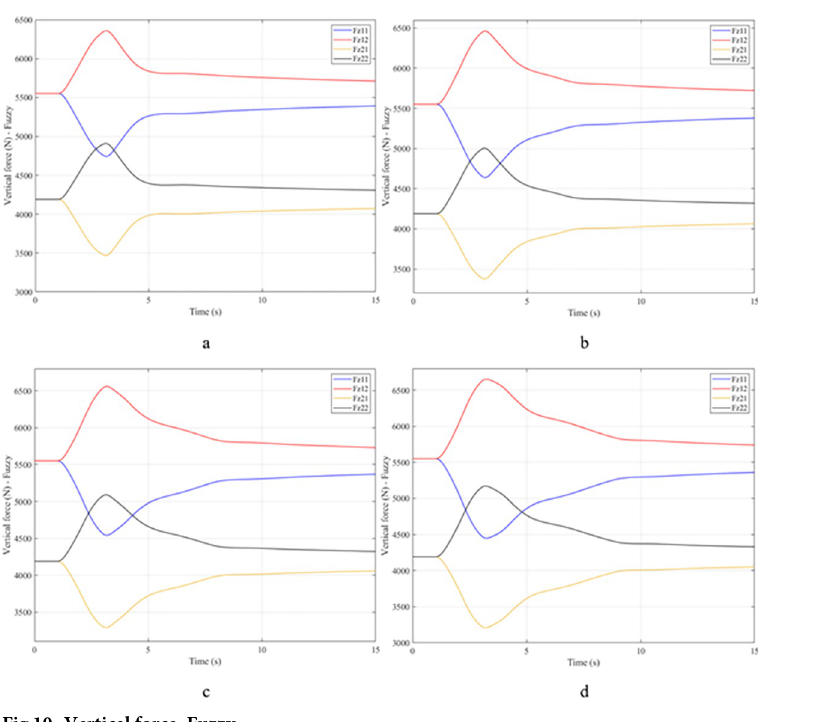
Fig 10. Vertical